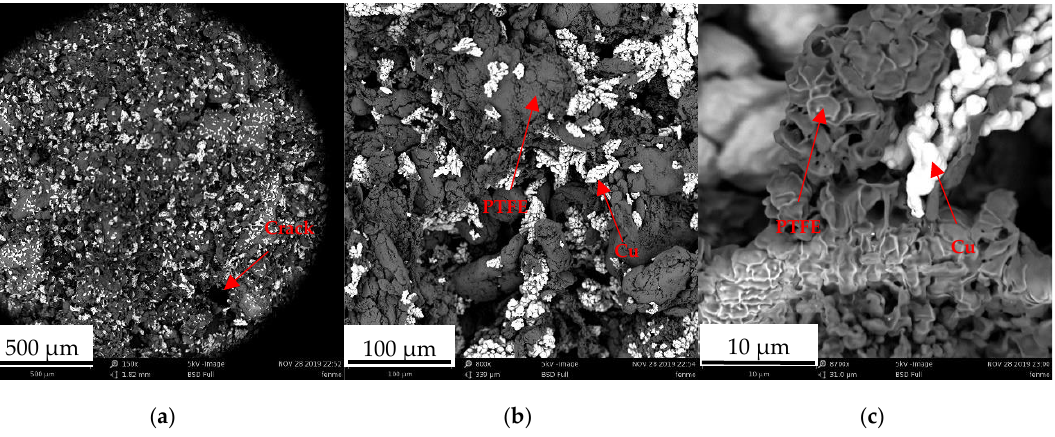
Figure 1. Scanning electron microscopy (SEM) micrograph of PTFE/Cu powder: ( a ) 500- μm scale; ( b ) 100- μm scale; ( c ) 10- μm scale.